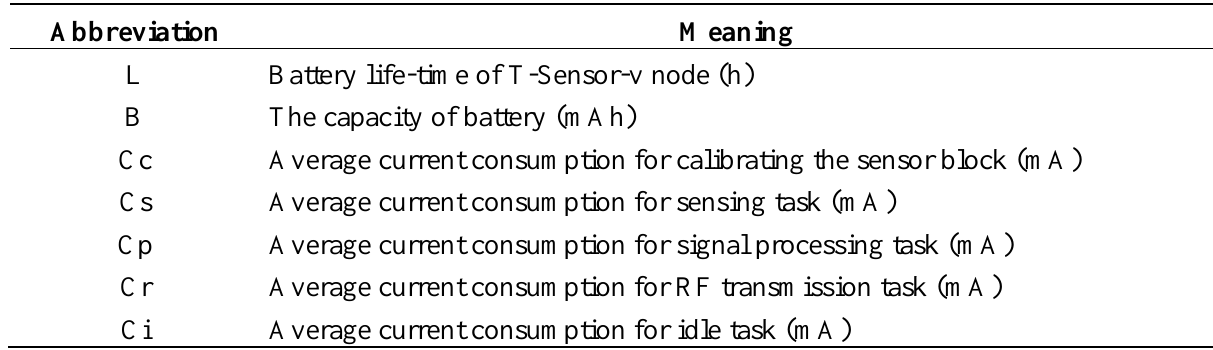
Table 6. Description for each parameter in